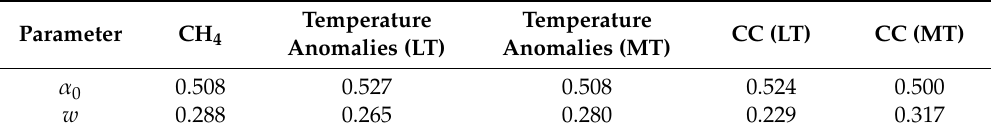
Table 2. Multifractal characteristics for the shu ffl ed time series of global CH 4 and the temperature anomalies of the global LT and MT and their cross-correlations